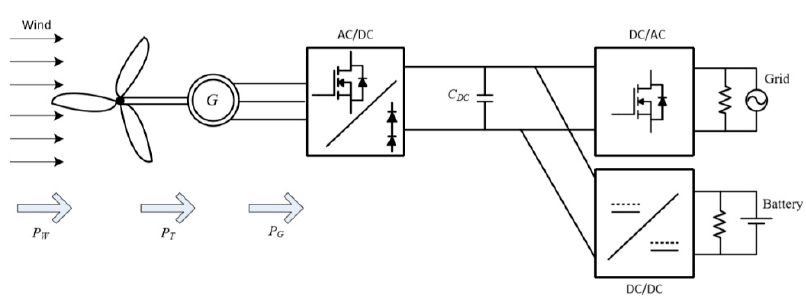
Figure 2. Illustration of interconnection of the wind energy conversion system